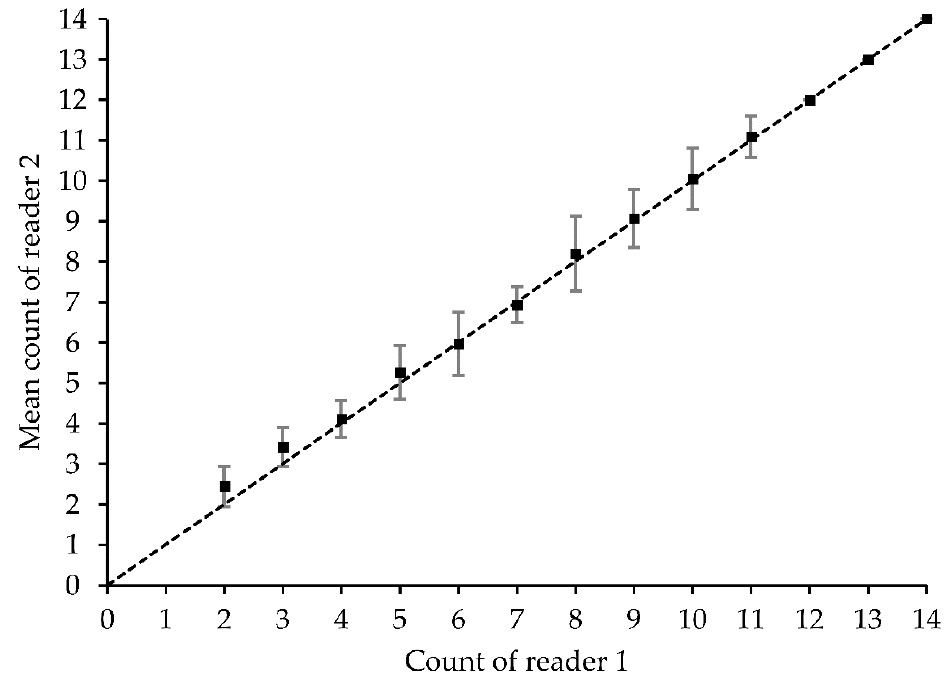
Figure 3. Age-bias plot of reader band-pair counts. Dots with standard deviation bars are the mean counts of reader 2 relative to reader 1. The diagonal line indicates a one-to-one relationship.